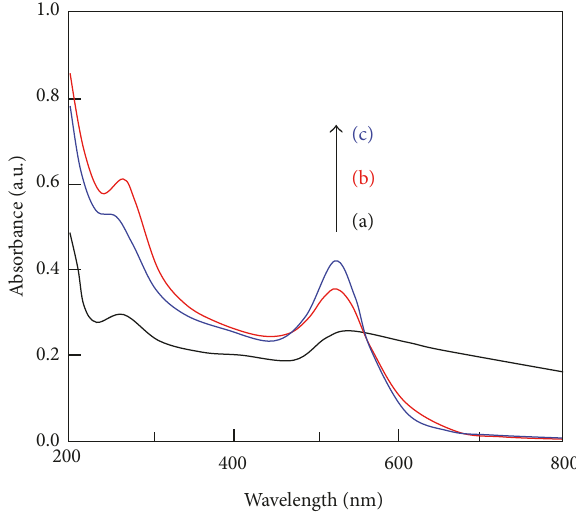
Figure 1: UV-Vis spectra of 1mM AuNPs/1% dextran solutions at different pH: 5.5 (a), 6.5 (b), and 7.5